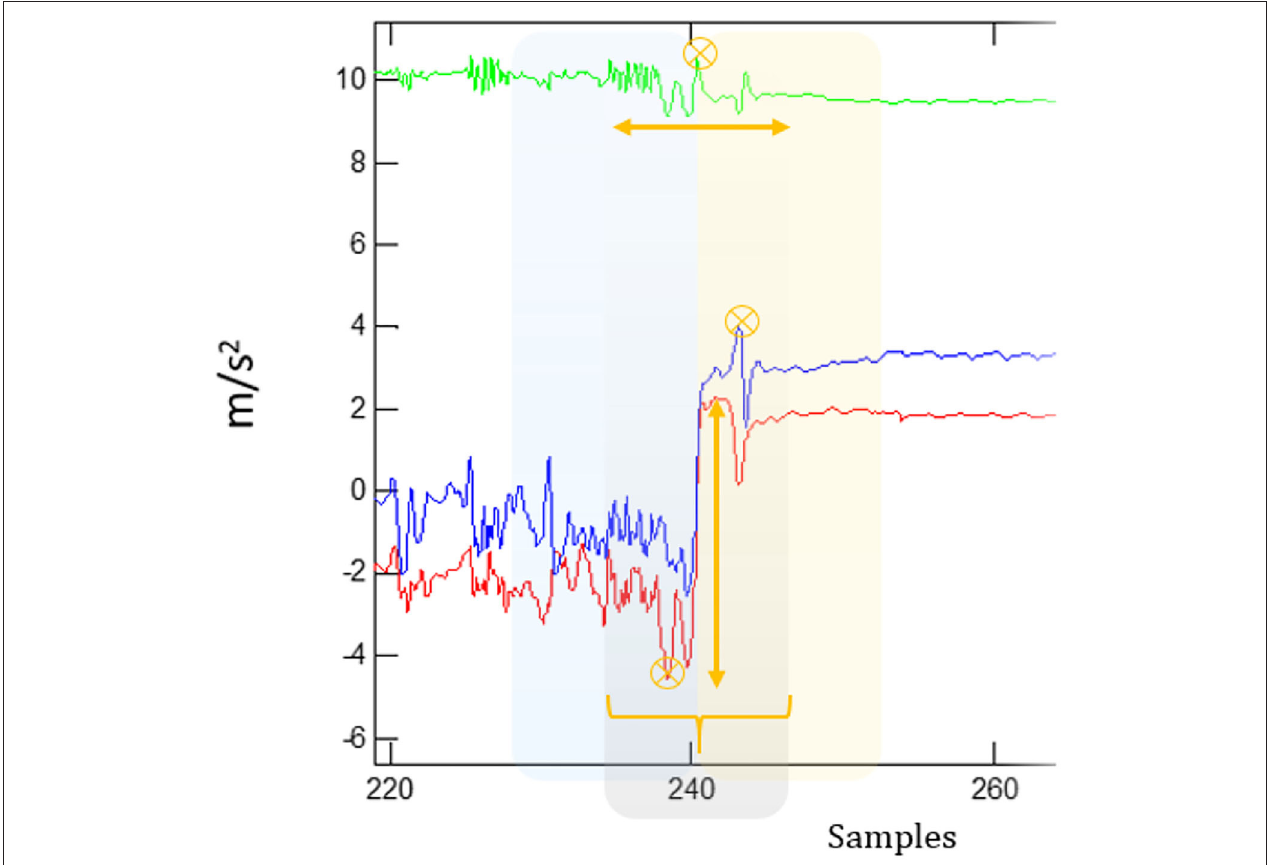
FIGURE 1 | Windowing of a signal at 50% overlapping and feature